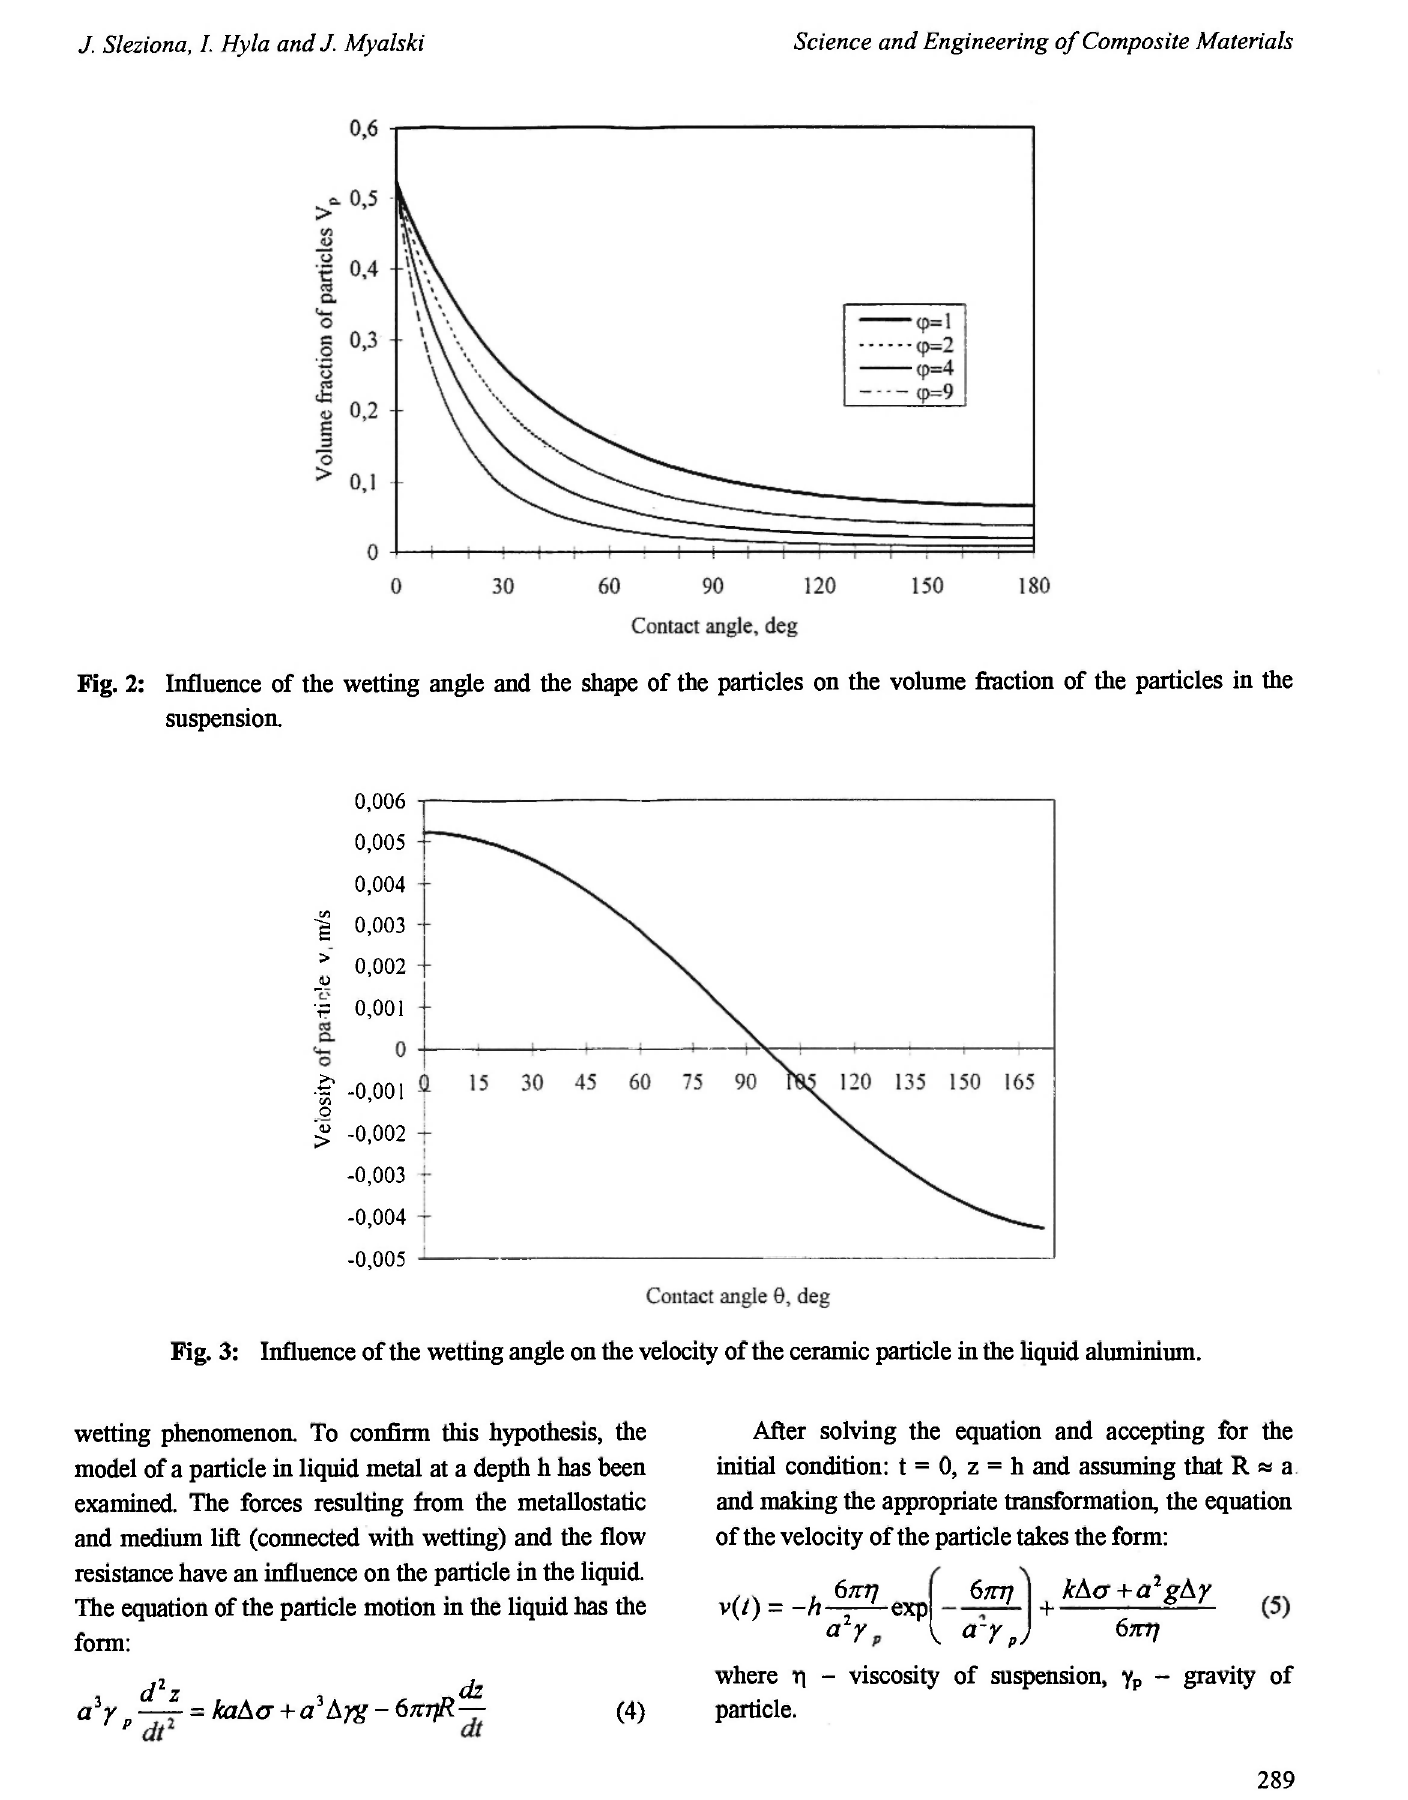
After solving the equation and accepting for the initial condition: t = 0, ζ = h and assuming that R « a and making the appropriate transformation, the equation of the velocity of the particle takes the form: where η - viscosity of suspension, γ - gravity of ρ